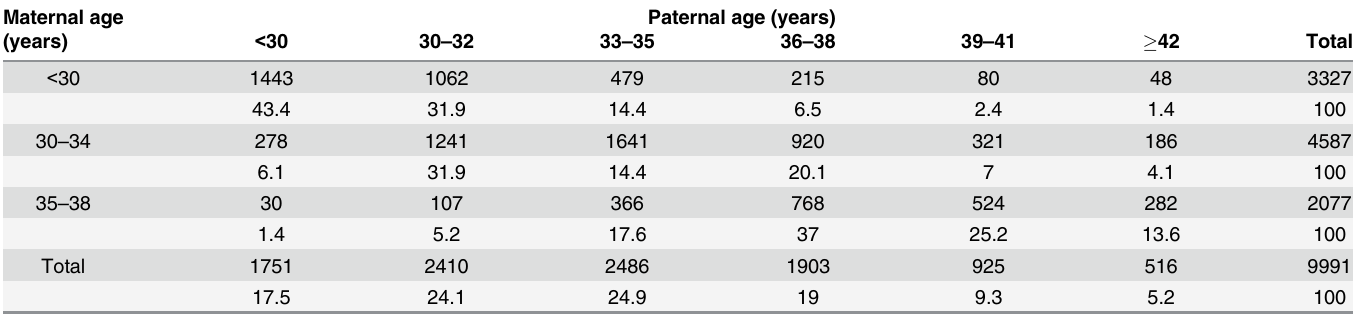
Table 1. Cycle distribution in the different age groups. Maternal age Paternal age (years)